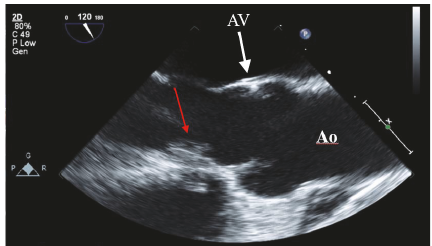
Figure 1: Initial EKG demonstrating accelerated junctional rhythm at 99 beats/minute with retrograde P wave conduction, QS duration 92 ms, and corrected QT interval 469 ms.